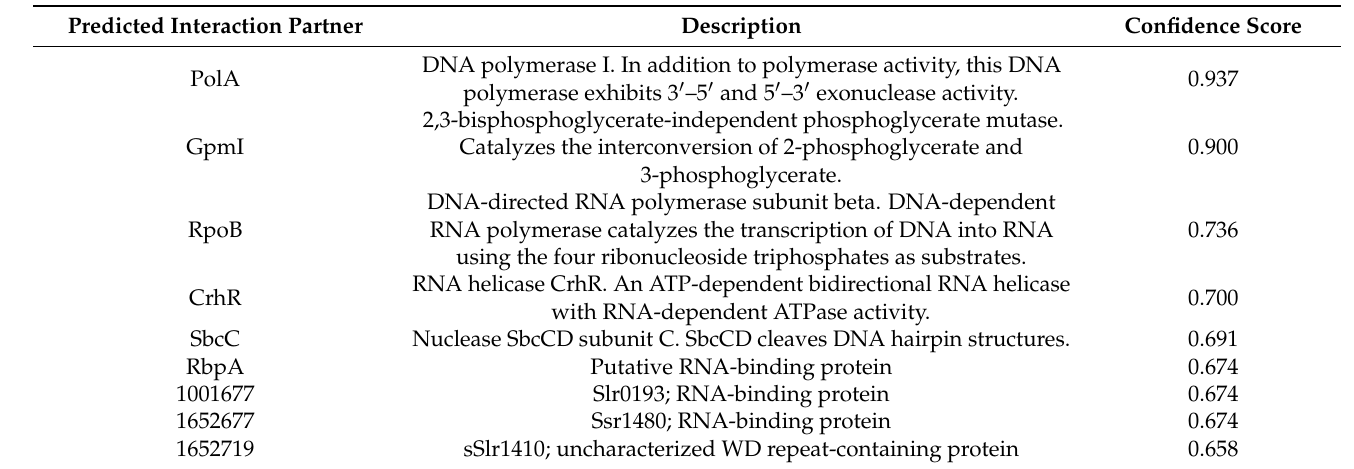
Figure 7. Protein–protein interaction network for PsoR homolog Sll0514 in Synechocystis sp. PCC 6803. A protein–protein interaction network was generated using STRING [42]. The Sll0514 protein sequence (GenBank ID: sll0514) from Synechocystis sp. PCC 6803 was used as a query. Edges represent functional associations with differently colored lines representing different types of interactions: red line, fusion of genes; green line, neighborhood of genes; blue line, co-occurrence across species; purple line, experimental evidence; yellow-green line, text mining; light blue line, database documentation; black line, co-expression data. Table 5. Proteins predicted to interact with Sll0514 from Synechocystis sp. PCC 6803 using the STRING